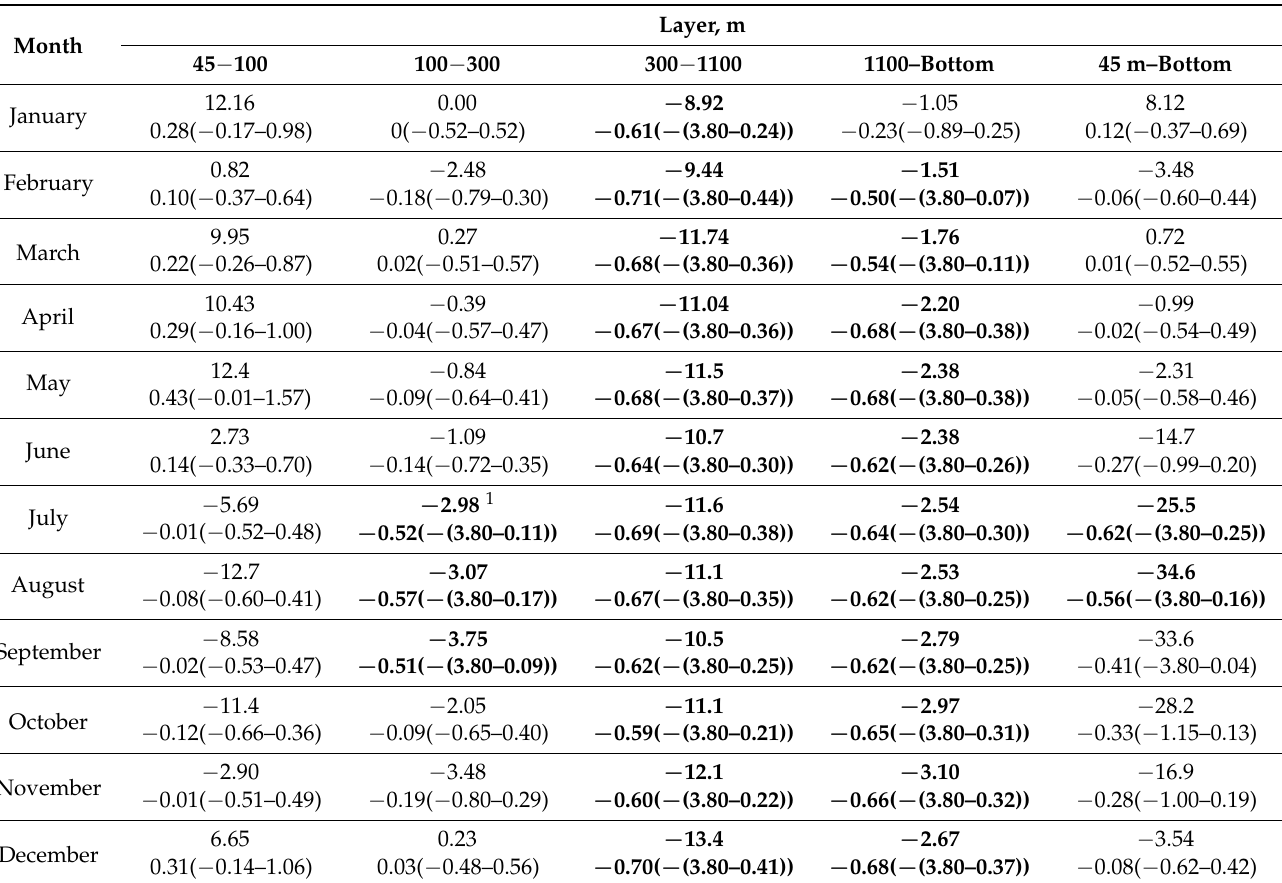
Table 2. Trends of the heat content in certain water layers (top row, (MJ/m 2 )/year), correlation coefficient (r, bottom row) and its confidence intervals (bottom row, in parentheses) at the p -value of